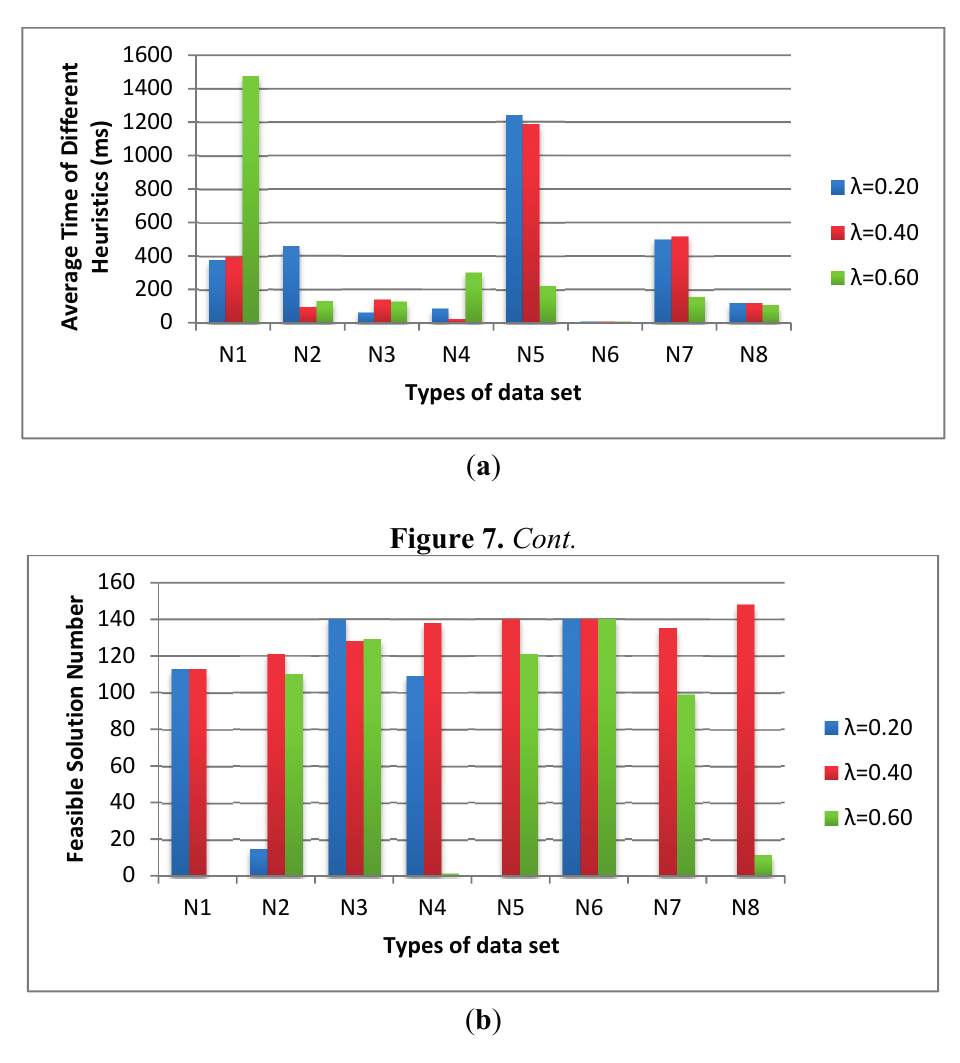
Figure 7. The influence of λ on ( a ) average time and ( b ) feasible solution